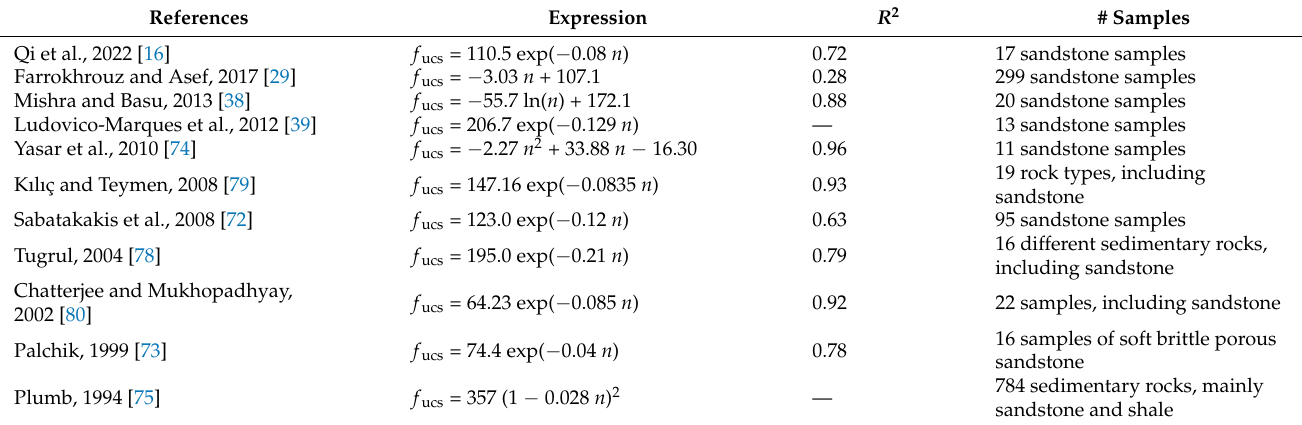
Table 7. Empirical expressions for UCS prediction based on porosity.